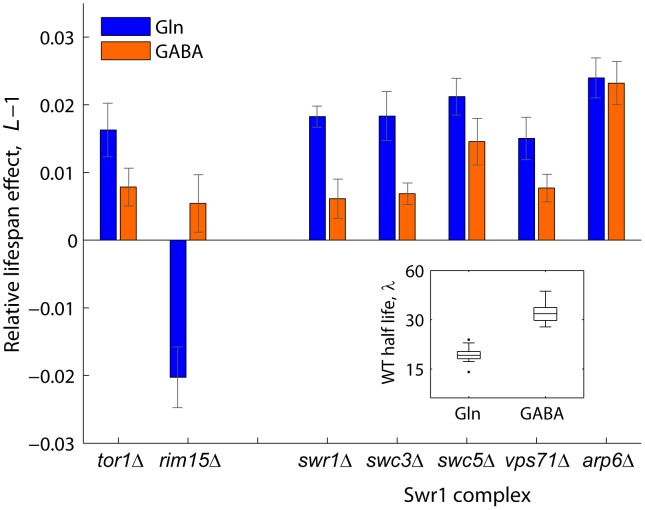
Relative lifespan extension by inactivation of Swr1 is partially abolished under dietary restriction.Bars show the relative lifespan effects (L−1) for mutant strains aged in competition against the WT in glutamine (rich nitrogen, blue bars) or GABA (poor nitrogen, orange bars) aging medium. Error bars indicate the standard error from at least three independent experiments. Box plot (inset) shows the absolute half life measurements of individual WT cultures aged under glutamine or GABA (n = 28).